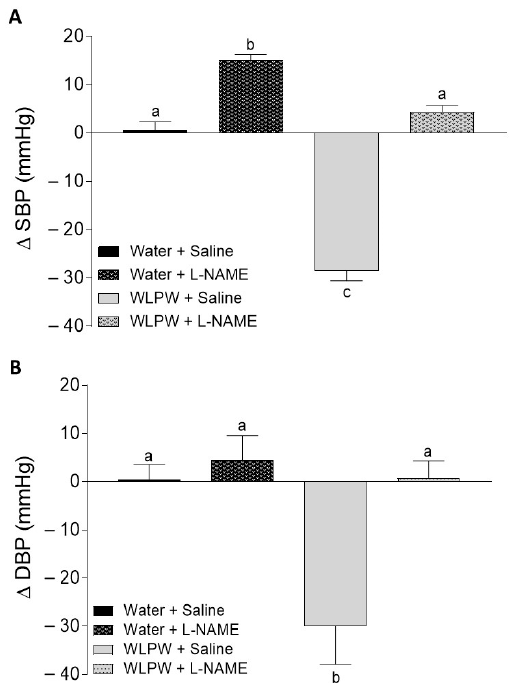
Figure 2. Changes in systolic blood pressure (SBP) ( A ) and diastolic blood pressure (DBP) ( B ) caused in spontaneously hypertensive rats 6 h post-administration by different treatments: oral administration of water or wine lees powder (WLPW) and intraperitoneal injection of Saline or N ω -nitro-L-arginine methyl ester hydrochloride (L-NAME). Significant differences ( p < 0.05) are represented by different letters and p was estimated by one-way ANOVA.